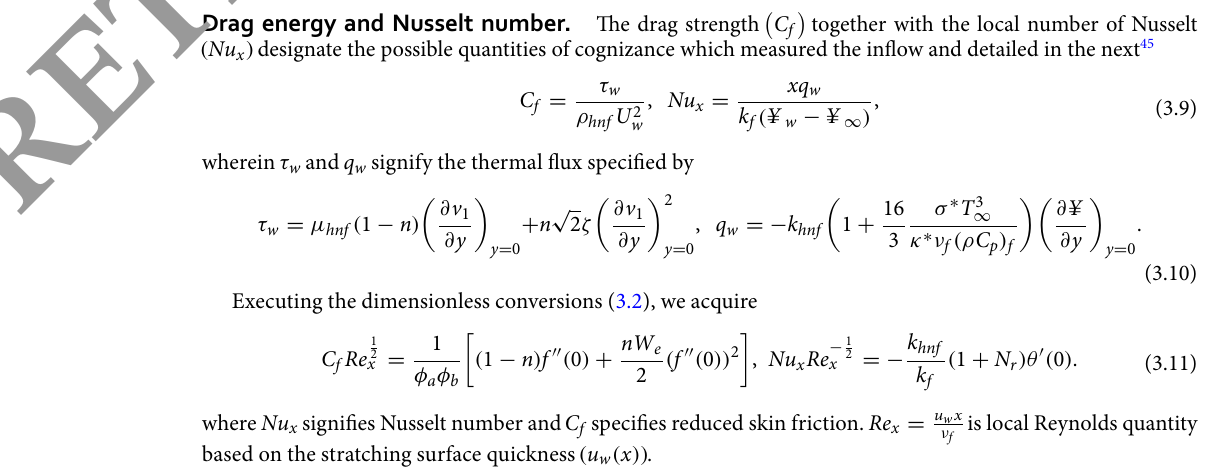
Executing the dimensionless conversions (3.2), we acquire